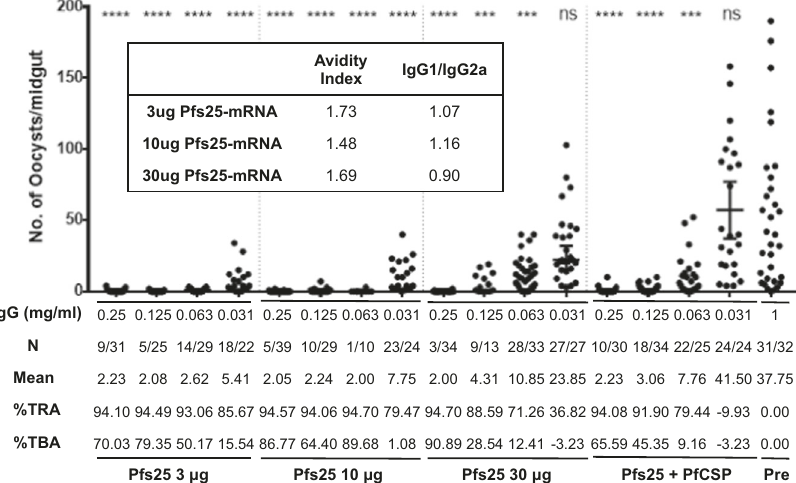
Fig. 4 Evaluation of transmission reducing activity of antibodies induced by Pfs25 mRNA-LNPs. IgG was puri fi ed from pooled sera collected from mice immunized with 3 μ g and 10 μ g of Pfs25 mRNA-LNP (FB1) and 30 μ g Pfs25 mRNA and 10 μ g of both Pfs25 + PfCSP mRNA- LNP combinations groups (FB2). Puri fi ed IgG were evaluated in mosquito standard membrane feeding assays (SMFA) at indicated fi nal concentrations (0.25, 0.125, 0.63, and 0.031 mg/ml). Data points representing the oocyst counts from each mosquito, arithmetic means, and 95% con fi dence intervals are reported. N is the fraction of uninfected mosquitoes over the total number of mosquitoes dissected. %TRA is the mean reduction in oocysts in the presence of the test IgG compared with the IgG (1 mg/ml) from pre-immune mouse sera (Pre) used as a negative control. %TBA is the percent reduction in the proportion of infected mosquitoes in the presence of the test IgG compared with pre- immune IgG negative control (Pre). The inset shows IgG1/IgG2a isotype ratios and antibody avidity index for sera evaluated by SMFA. Statistical analysis was performed using the Mann – Whitney U test (ns p > 0.05; * p < 0.05; ** p < 0.01; *** p < 0.001; **** p < 0.0001).